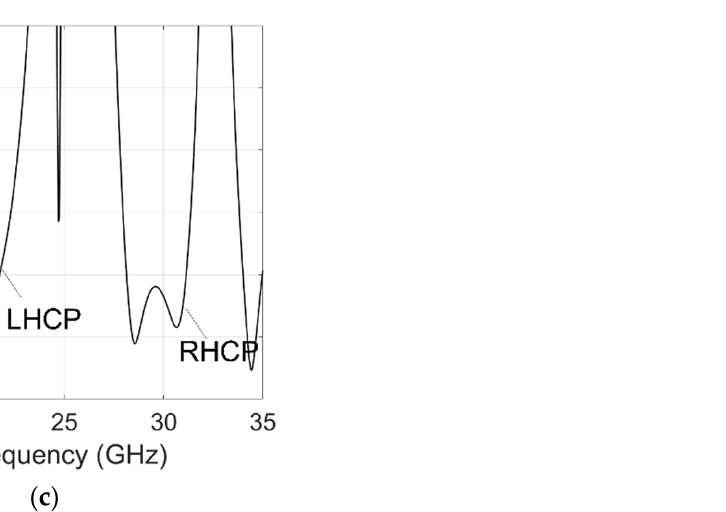
Figure 7. HFSS simulated results of the elementary cell. ( a ) The module of the transmission coefficient: Continuous line, x-polarization; dashed line, y-polarization. ( b ) Transmission coefficient phase difference. ( c ) Axial Ratio.